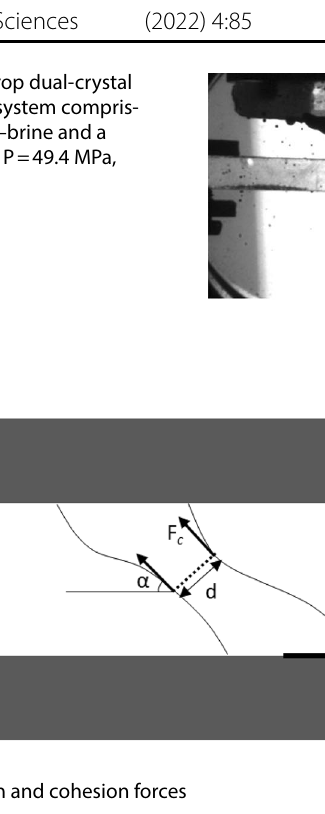
Fig. 9 Ahesion and cohesion